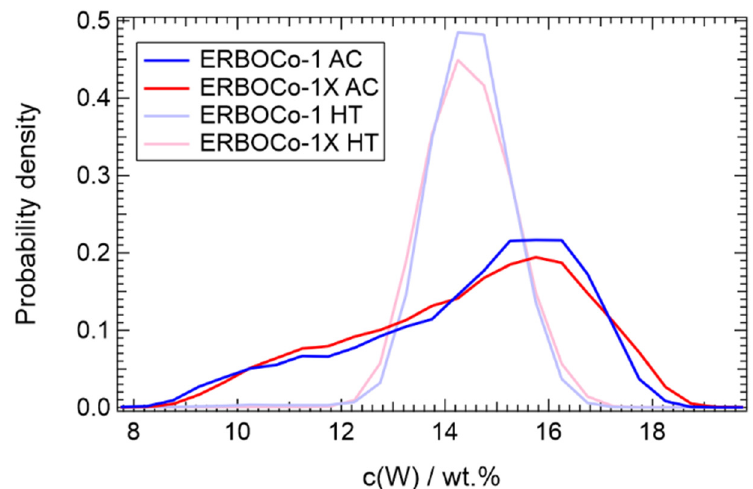
Figure 2. Histograms of the W concentrations in ERBOCo-1 and ERBOCo-1X in the as-cast (AC) and heat-treated (HT) conditions (1280 °C/8 h + 1050 °C/5 h + 900 °C/16 h).